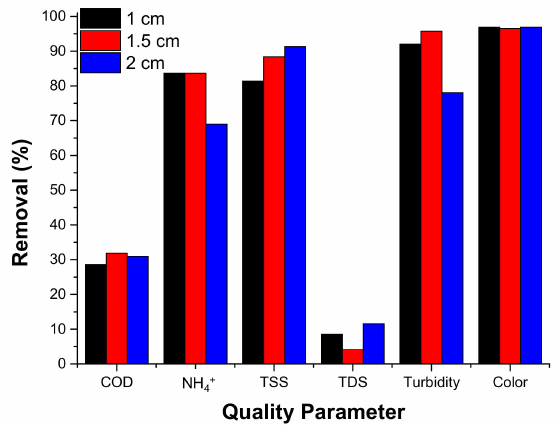
Figure 5. The removal rate of COD, NH 4+ , TDS, TSS, turbidity, and color in several distances between electrodes (pH = 7.5; current density = 64 mA/cm 2 ; electrolysis time = 120 min; temperature = 20 ◦